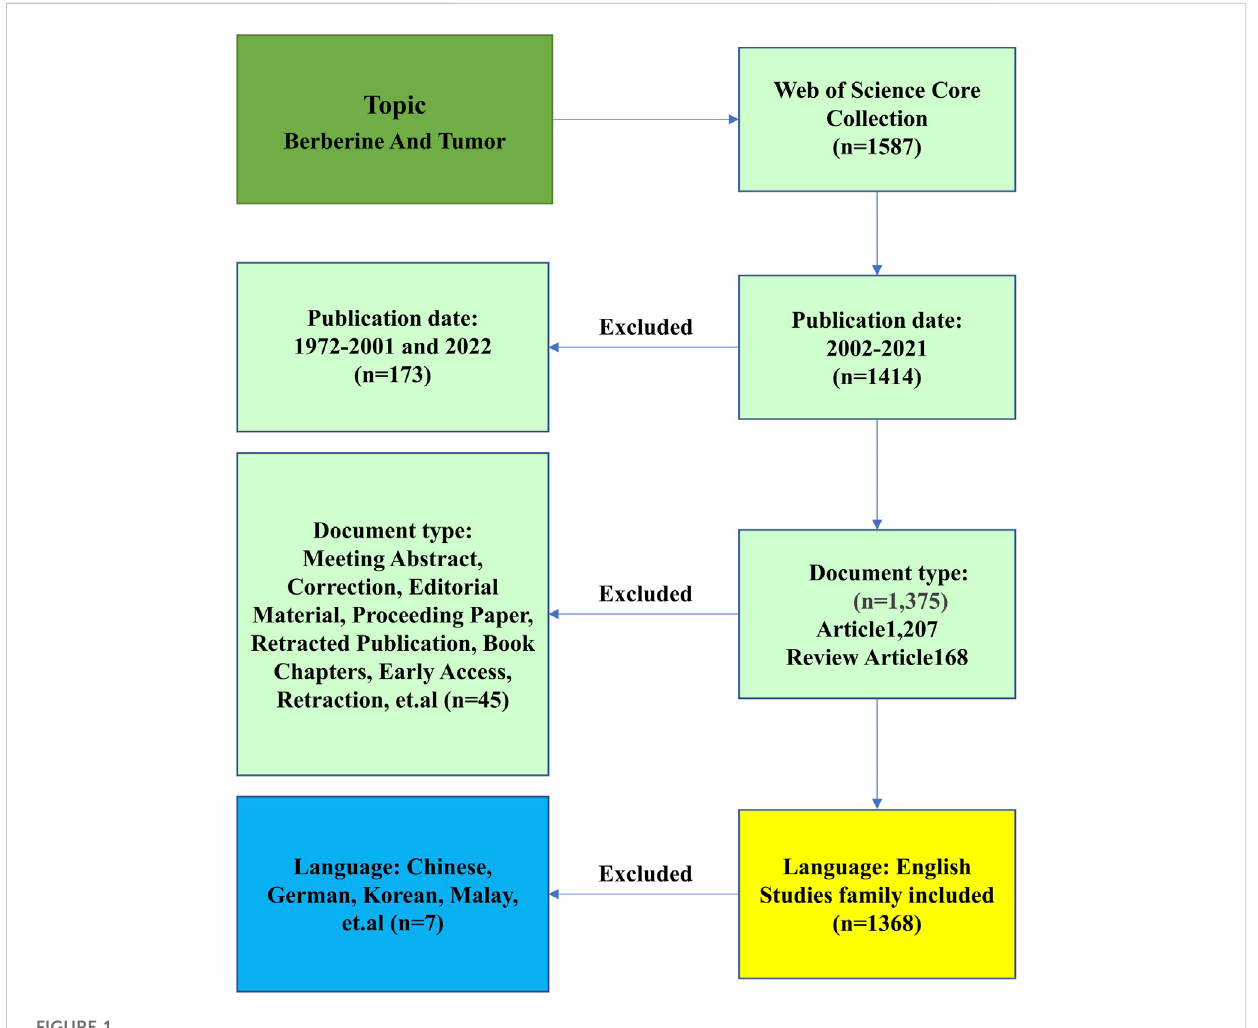
FIGURE 1 Flowchart of the screening